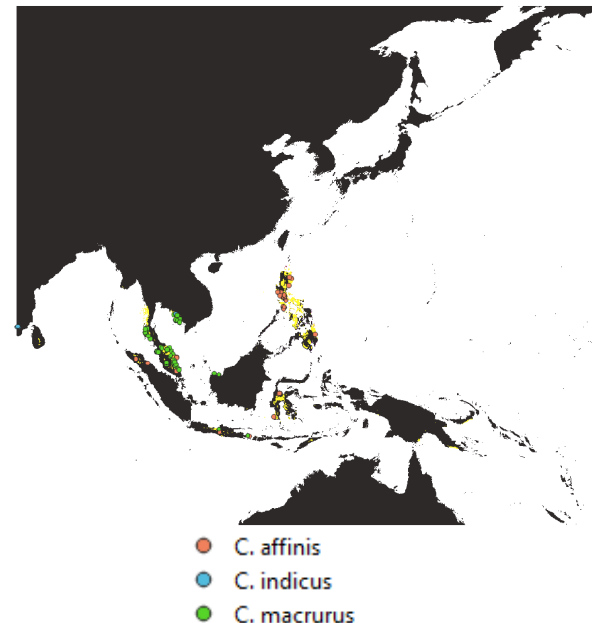
Figure 8. Occurrence of Caprimulgus within the Philippines’ vicinity